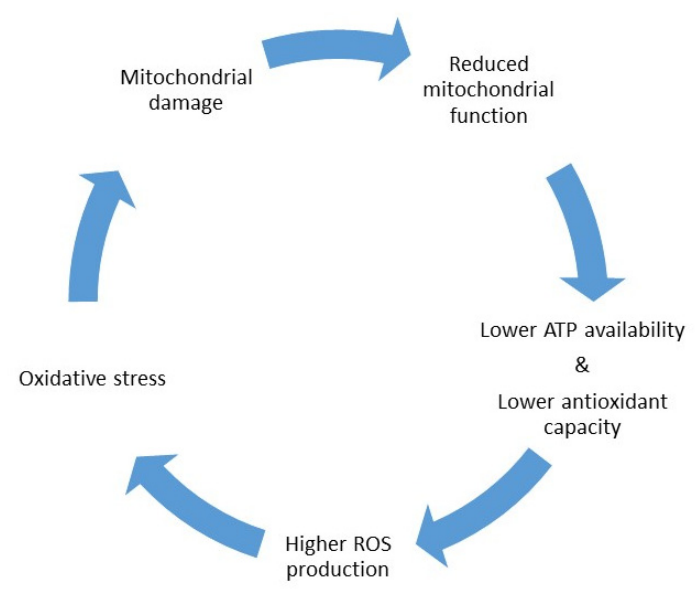
Figure 2. Vicious cycle between mitochondrial dysfunction and oxidative stress damage.